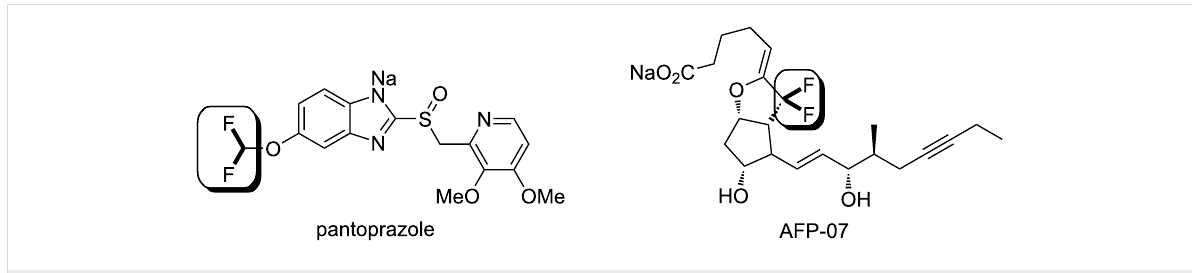
Figure 1: Medical compounds having a difluoromethyl group.